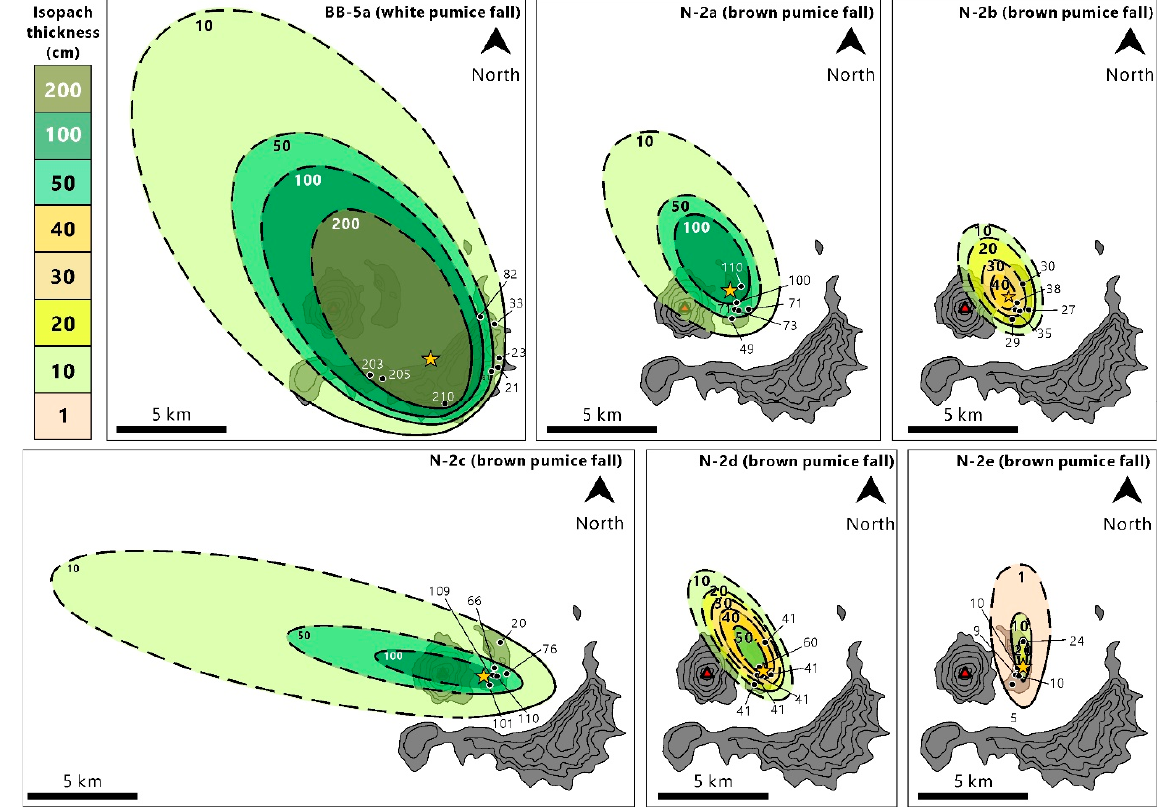
Figure 9. Isopach maps of pyroclastic fall phases of Banda Besar white pumice fall (BB-5a) and Naira brown pumice falls (N-2a-e). This research assumed an ellipsoidal shape e.g., the ellipse-approxi- mated isopach (EAI) method of Tajima et al. 2013) [25] to connect the ‘missing’ isopach line (shown by dashed line) for each isopach contour. The results suggest that most of the tephra were distrib- uted in the west-northwest direction (except for N-2e), in agreement with the wind direction data from the Meteorological, Climatological, and Geophysical Agency of Indonesia [17]. Vent(s) posi- tion(s) (as shown by the yellow star symbol) were obtained by assuming a location with the thickest deposit with minimum wind influence. There is an indication of vent migration during the eruption of Naira, as suggested by the relatively northern vent position for N-2a and 2b, and the southern vent position for N-2c, 2d, and 2e.